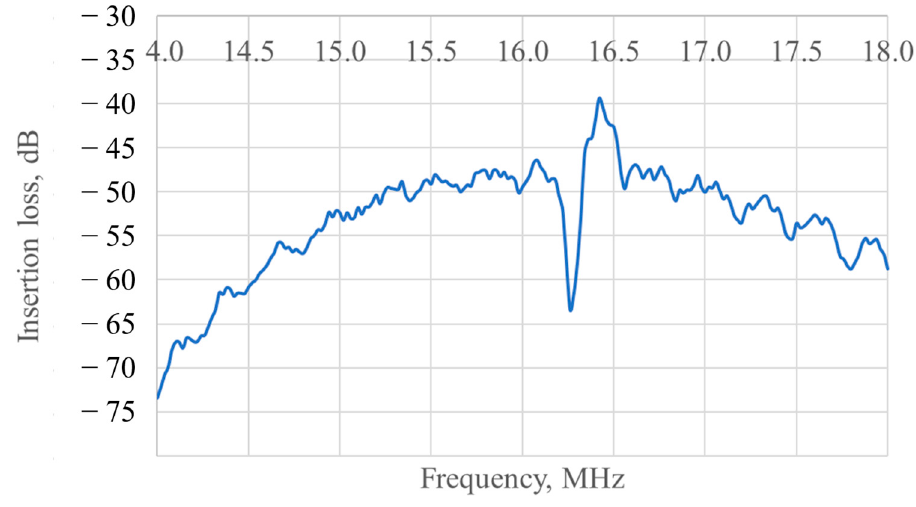
Figure 7. Frequency response of the prototype in the delay line regime.